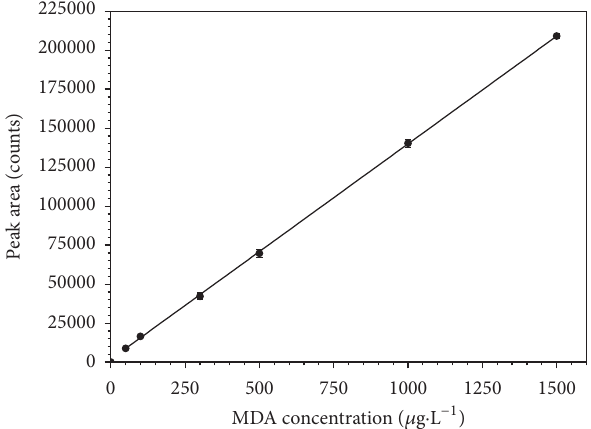
Figure 4: MDA calibration curve. MDA concentrations tested between 10 and 1500 𝜇 g ⋅ L −1 . Regression line: 𝑦 = 2400 + 134 𝑥 , with 𝑅 2 =